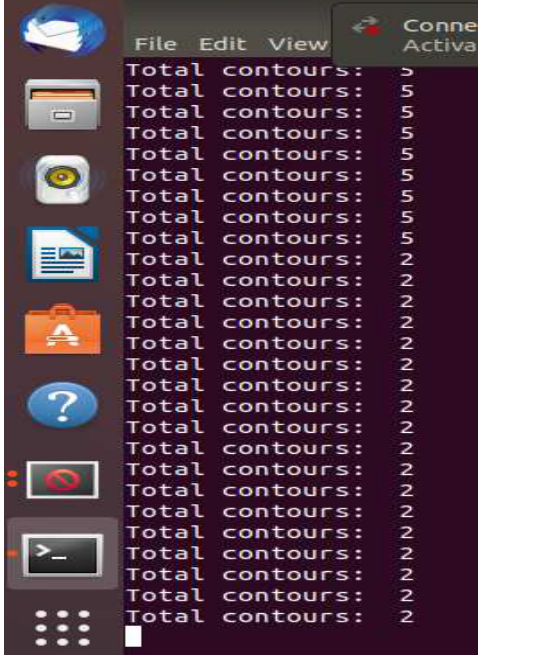
Figure 8. Density